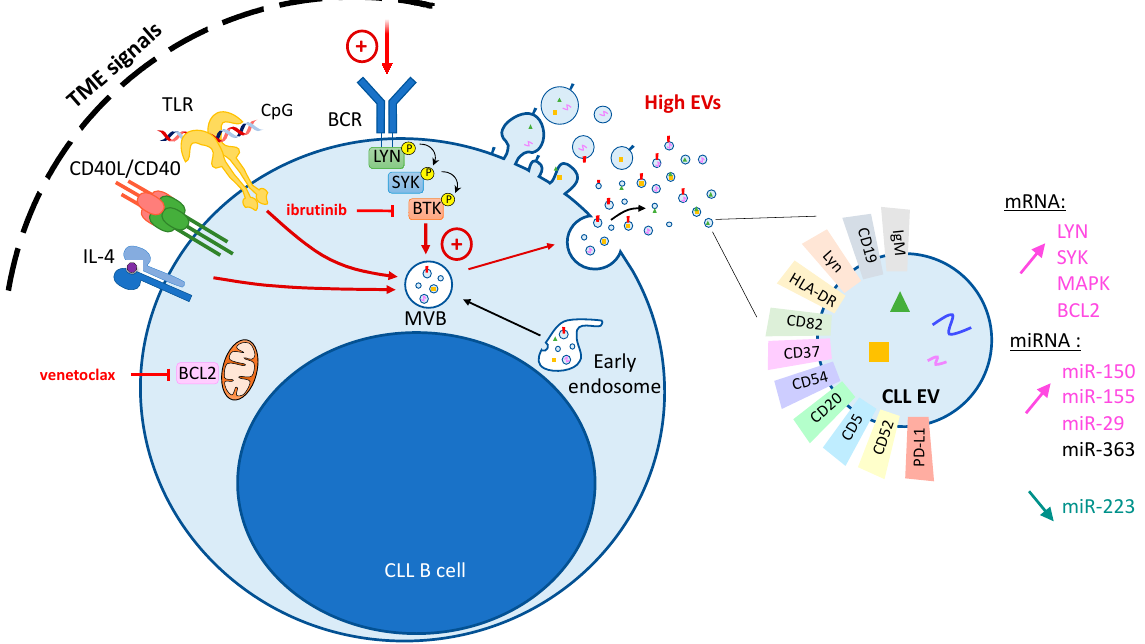
Figure 1. Modulation of EVs in CLL. The fusion of MVBs (multivesicular bodies) with plasma membrane or the budding of the plasma membrane leads to the release of CLL EVs from CLL B cells. EVs’ release can be increased by TME (tumor microenvironment) signals recapitulated by the stimulation of the BCR (B-cell receptor), TLR (Toll-like receptors) signaling, or CD40/IL-4 (left panel). CLL EVs are characterized by the exposure of specific surface markers (right panel). Compared to normal B cell EVs, CLL EVs contain a higher level of LYN, SYK, MAPK and BCL2 mRNAs, as well as a higher level of miR-150, miR-155, and miR-29 but a lower level of miR-223. TME stimulation increases their miR-363 content (BTK—Bruton’s tyrosine kinase; LYN—Lck/Yes novel tyrosine kinase; SYK—spleen tyrosine